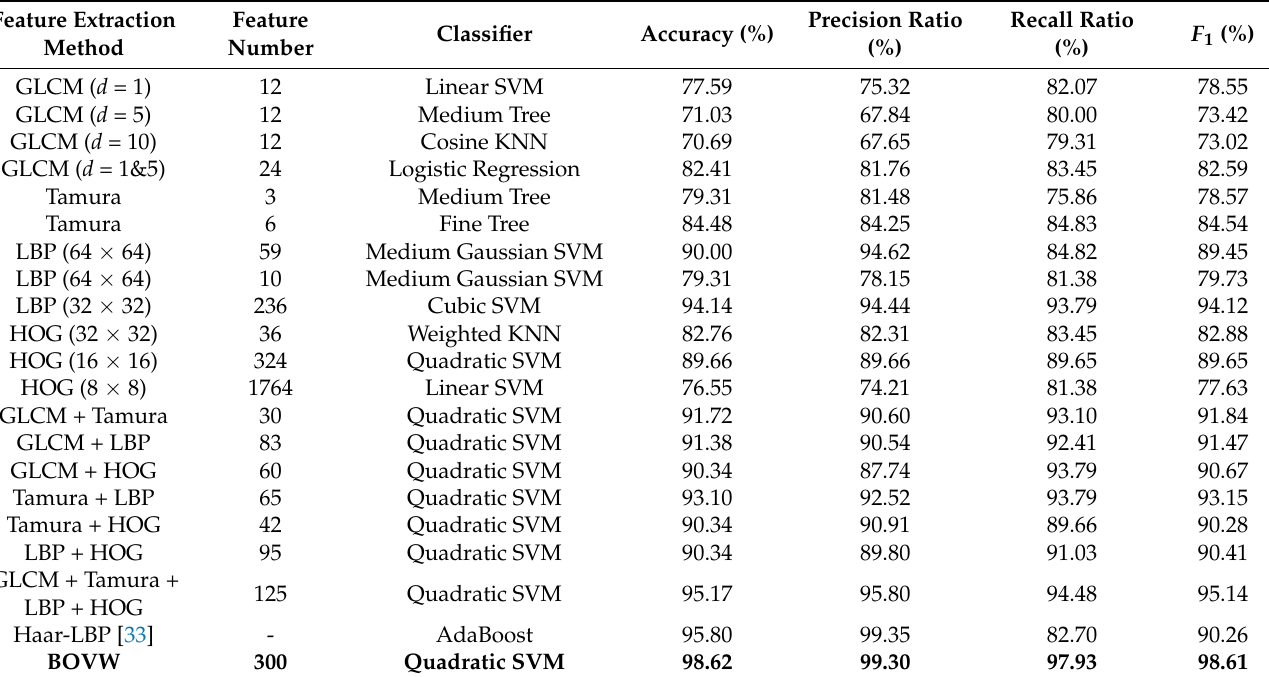
Table 6. Comparison validation accuracies of various feature extraction and